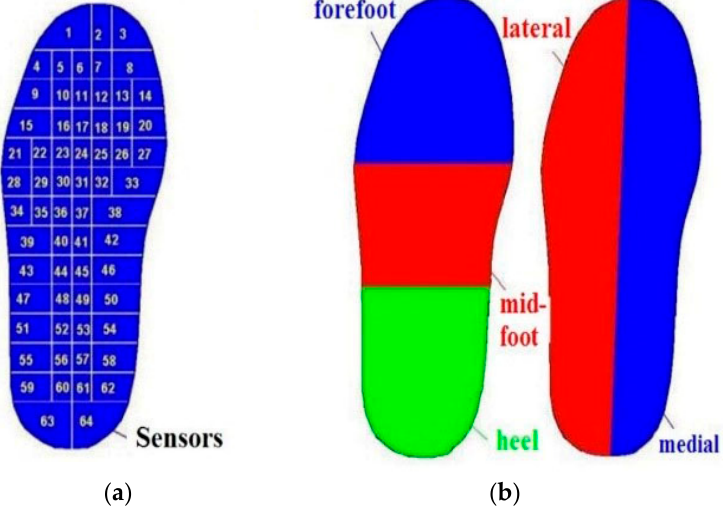
Figure 2. ( a ) Composition of insole pressure sensors with a pressure range of 0–64 N / cm 2 ; ( b ) region Figure 2. (a) Composition of insole pressure sensors with a pressure range of 0-64 N/cm 2 ; (b) region divisionofplantarpressure, includingtheforefoot, themidfoot, theheel, thelateral, division of plantar pressure, including the forefoot, the midfoot, the heel, the lateral, and the medial parts.